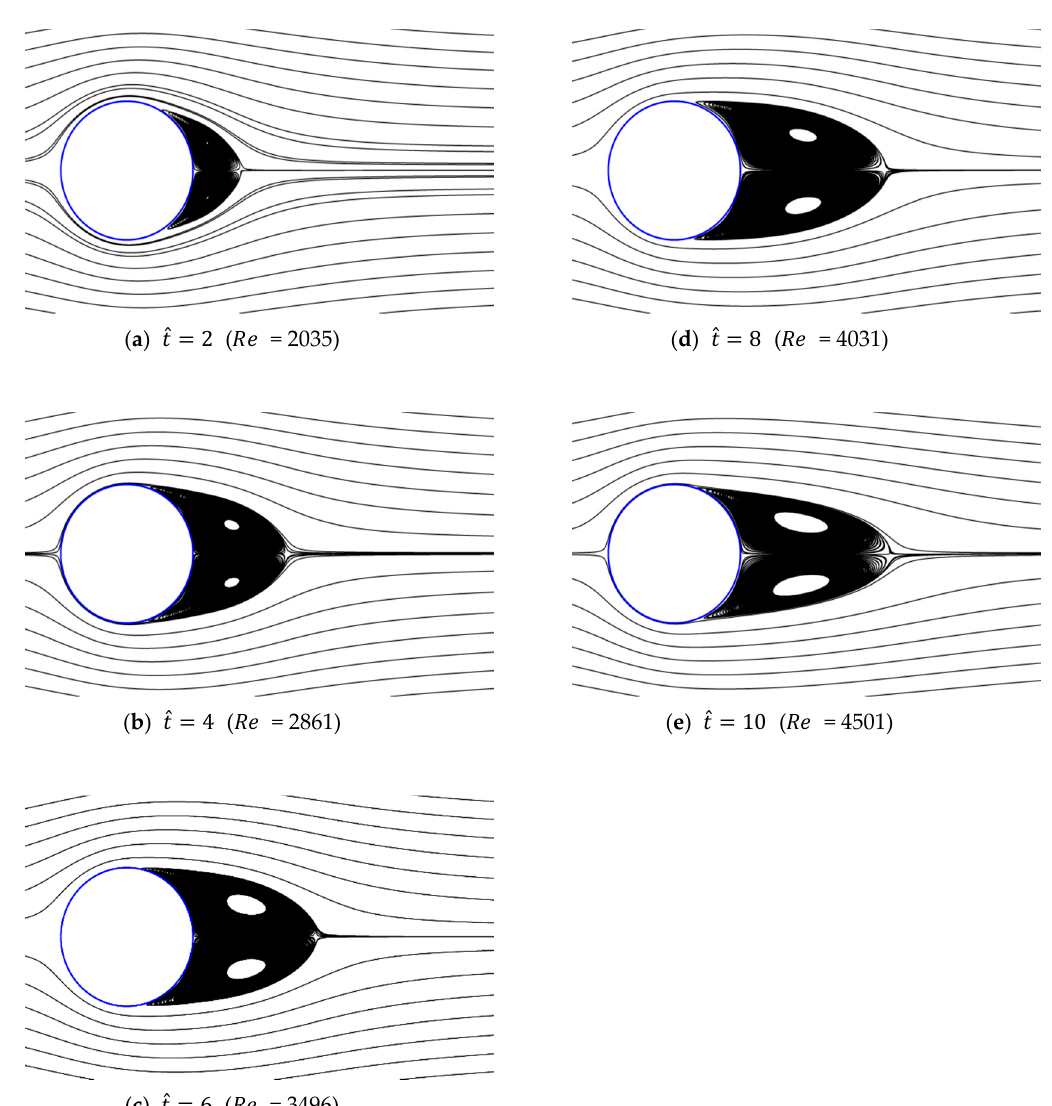
Figure 16. Streamlines around circular cylinder ( a / g = 0.05, Re 0 = 40 )